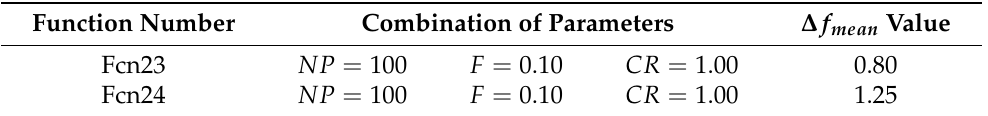
Table 6. The third case objective functions, the used combination of parameters and the mean fitness value ∆ f mean